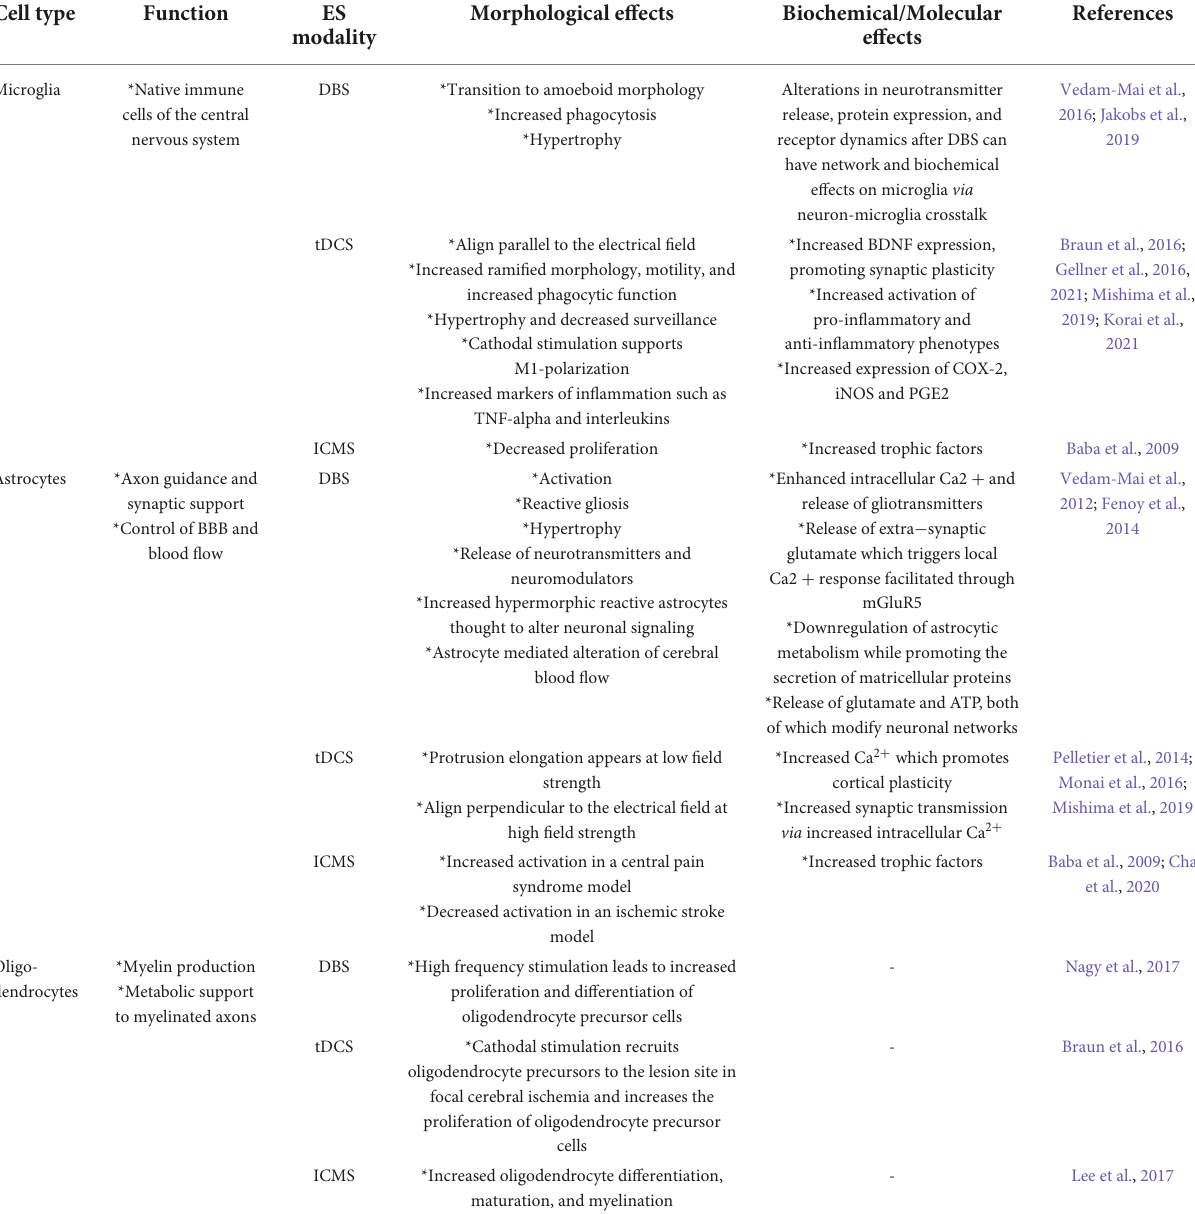
TABLE 2 Summary of the major effects of electrical stimulation on non-neuronal cells for the modalities